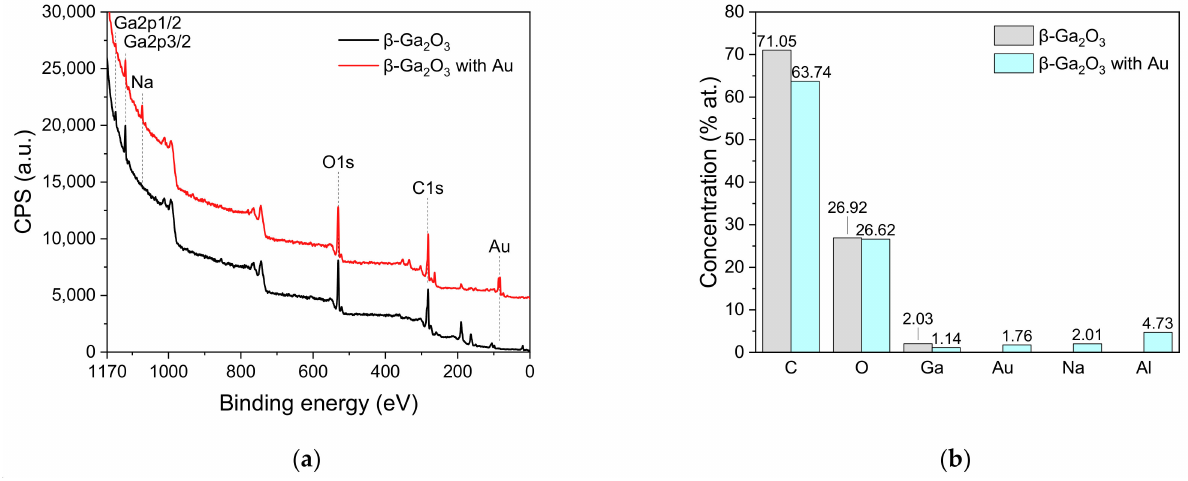
Figure 6. ( a ) XPS survey spectra of β -Ga 2 O 3 epitaxial layer before and after impregnation with Au nanoparticles; ( b ) concentration of atoms present on the analyzed